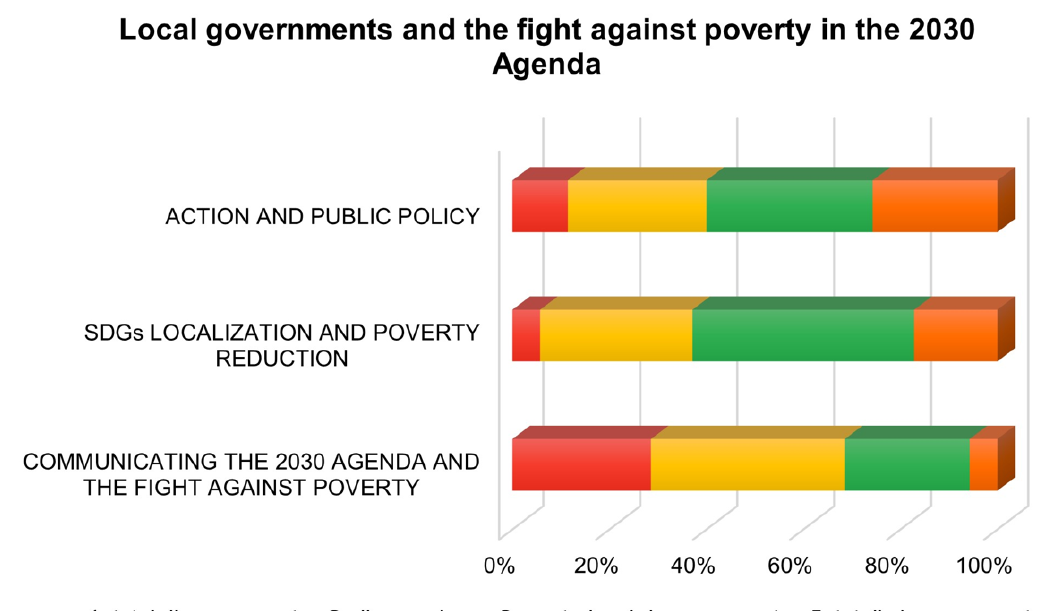
Figure 7. Local governments and the fight against poverty in the 2030 Agenda.